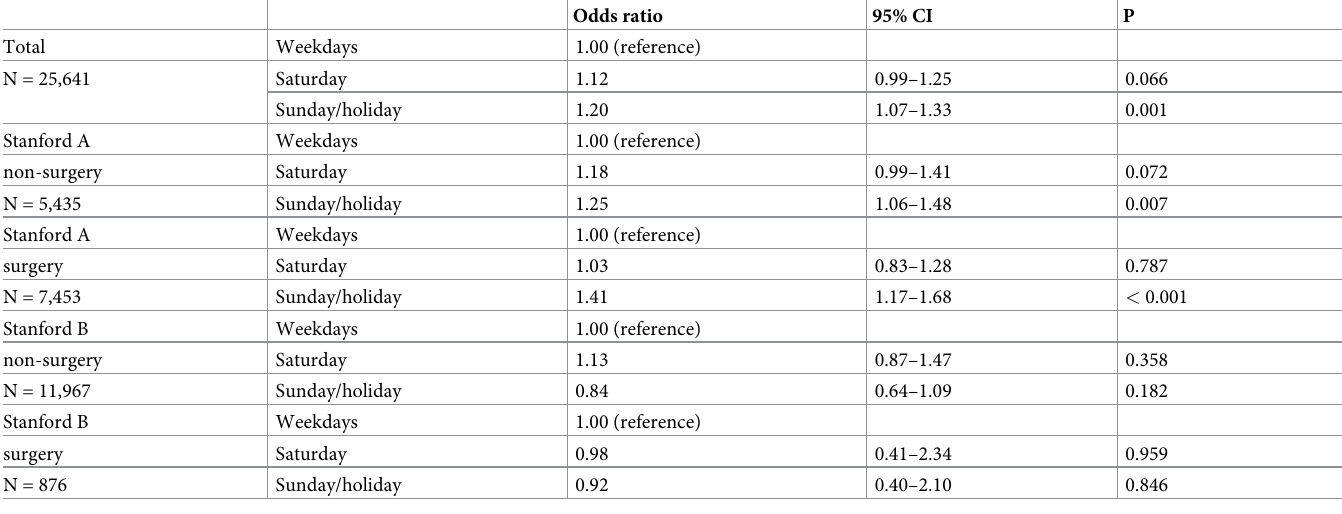
Table 3. In-hospital mortality per weekday, Saturday,